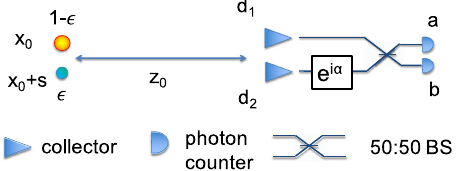
Fig.2|Schematicoftwosourceswithaseparationof s intheobjectplane,with relative intensities ϵ and 1 − ϵ , at a distance z 0 from the collectors. Two col- lectorsat d 1 and d 2 directlightintoatwo-inputinterferometerconsistingofaphase shiftof α anda50:50beamsplitter,followedbyphotoncounters.Acollectorcanbe any optical element that collects light. Thiscould incorporate lenses or in the case of this experiment, two fi bre connectors that present only the bare fi bre core diameters in the direction of the